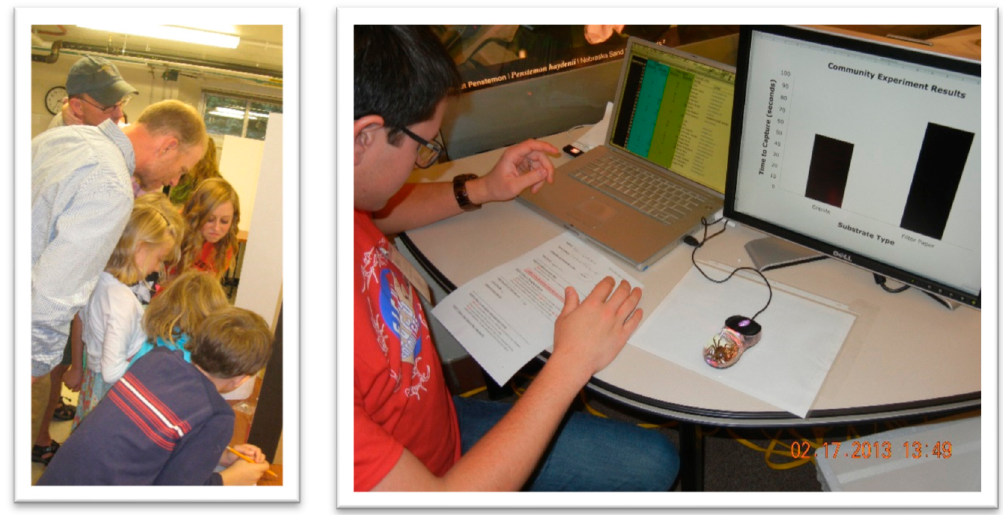
Figure 4. Families gather around an arena to watch and collect data on a spider attacking a cricket in the Community Experiment (LEFT photo) and then enter their data into the computer and view the results of the experiment in real-time (RIGHT photo).